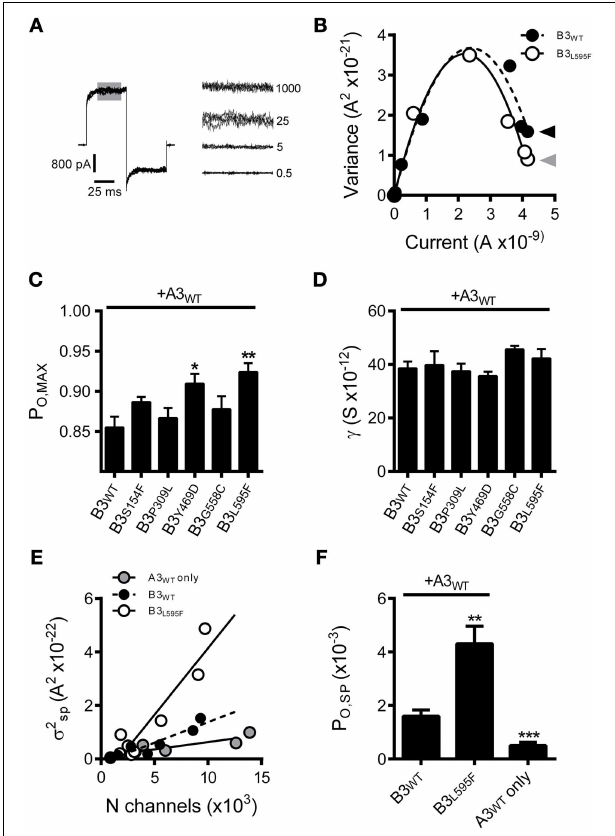
FIGURE 3 | Effects of CNGB3 disease-associated mutations on the absolute agonist efficacy of cGMP and the spontaneous open probability. ( A , Left ) Overlay of four current traces from A3 + B3 channels, activated by a sub-saturating concentration of cGMP (25 µ M) to produce an approximately half-maximal current amplitude. Shaded area indicates the region of interest (ROI) used for the calculation of mean current and mean isochrone variance for each concentration of cGMP. ( A , Right ) ROI overlays at various cGMP concentrations ( µ M cGMP indicated on the right). Current and variance calculations were performed as described in the Materials and Methods. The mean isochrone variance is minimal at extreme low and high open probabilities and maximizes at 50% open probability. For wild type cone CNG channels, ∼ 50% open probability is achieved at cGMP concentrations near the K 1 / 2 . The mean isochrone variance at saturating cGMP (i.e., 1mM) reflects the maximum open probability ( P O , MAX ), such that a decreased variance indicates an increased P O , MAX (provided that P O , MAX > 50%). (B) Current-variance plot for A3 + B3 wild type (closed circles) and A3 + B3 L595F (open circles) after activation by cGMP at + 80mV. The L595F mean current and variance estimates were scaled to WT I MAX to facilitate comparison of the initial slope from zero current and the variance at saturating ligand concentrations. Continuous lines produced by fitting with a 2nd order polynomial, as described in the Materials and Methods, using the following best-fit parameters: WT (solid), i = 3 . 1 pA, N = 1550 channels; L595F (hashed), i = 3 . 2 pA, N = 1370 channels. The mean variance at saturating cGMP is reduced for L595F channels (gray arrowhead) compared to WT channels (black arrowhead), indicating an increased P O , MAX for L595F channels. (C) Summary of maximal open probabilities after activation with saturating cGMP (1mM). Maximal open probabilities were calculated as described in the Materials and Methods. The P O , MAX was significantly increased for Y469D and L595F channels compared to wild type ( p < 0 . 01 , single-factor ANOVA, n = 4 –9; Holm’s t -test, * p < 0 . 05 , ** p < 0 . 01